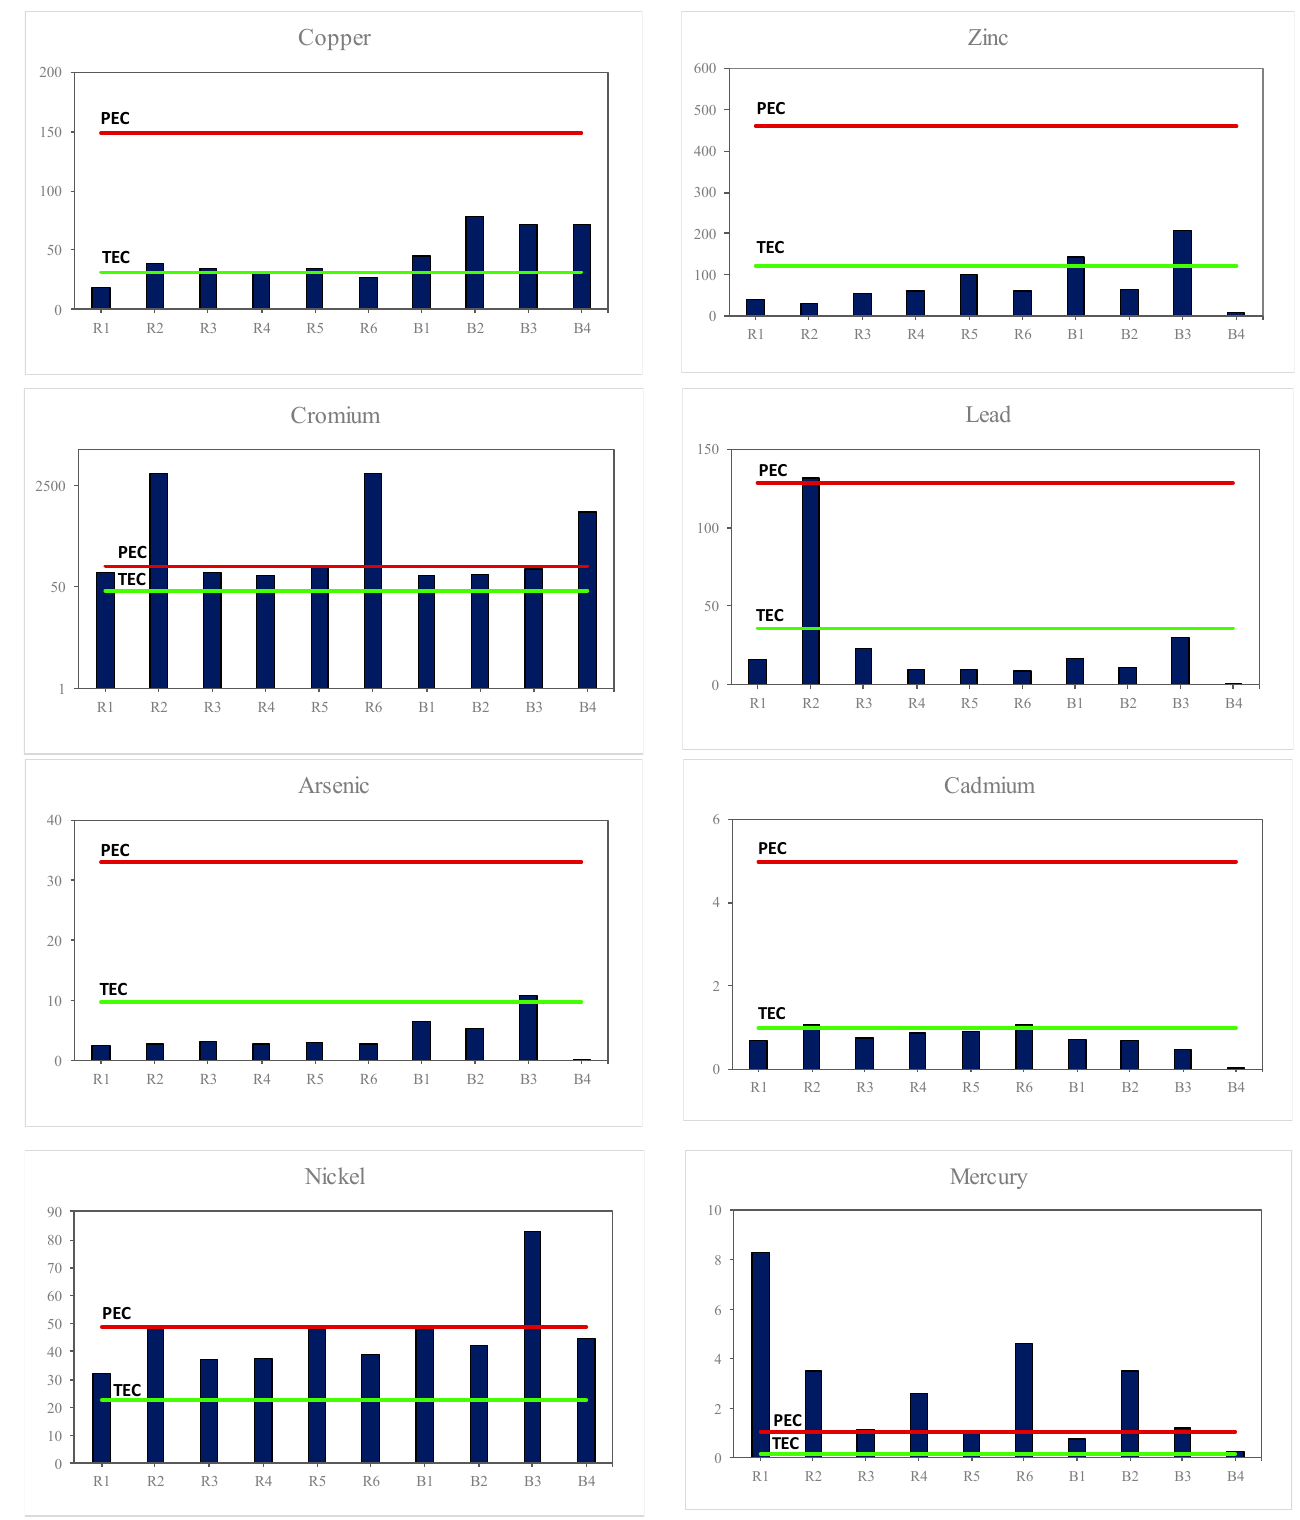
Figure 9. Comparison between TE concentrations (mg/kg) of all samples with sediment quality control guidelines and PEC ratio values (mg/kg).